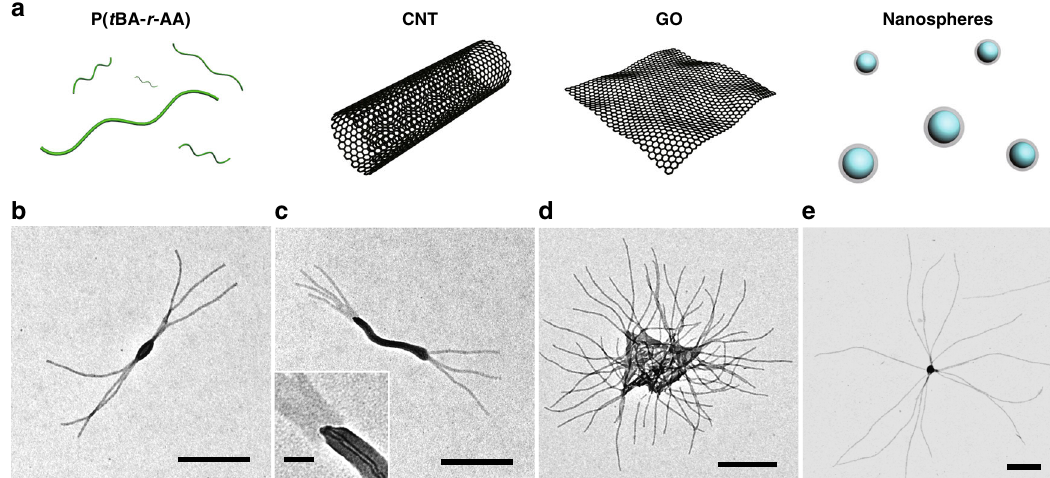
Fig. 4 The initiated assembly by macromolecular initiators. a Schematic cartoons of the different large initiators. b – e The TEM images of the hierarchical structures initiated by b P( t BA- r -AA) ( R I = 2 wt.%; C P = 0.05mg/mL); c CNTs ( R I = 10 wt.%; C P = 0.025 mg/mL); d GOs ( R I = 2 wt.%; C P = 0.05mg/mL), and e PS nanospheres (NS, R I = 2 wt.%; C P = 0.025 mg/mL). Scale bars are 500nm, and 50nm in the